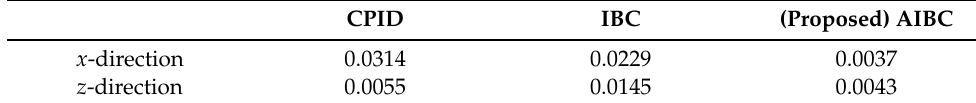
Table 3. The RMSE of tracking errors for different approaches.